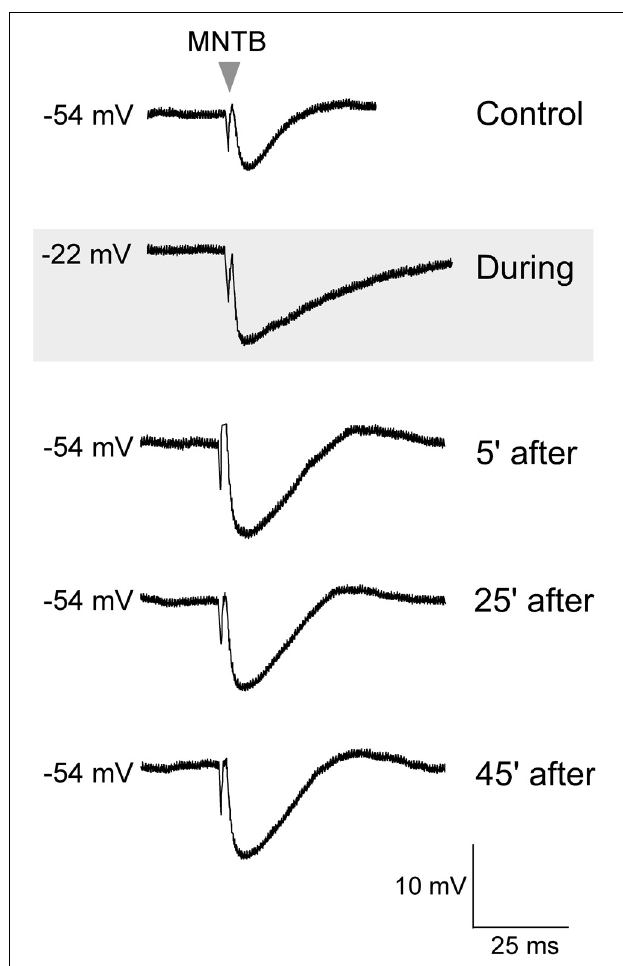
FIGURE 2 | Glutamate exposure potentiated MNTB-evoked IPSPs. Control MNTB-evoked IPSPs were recorded at 0.033Hz. An initial response is shown in the top trace. While continuing with this stimulation, glutamate (10mM) was bath perfused (45s), and the neuron became depolarized (gray panel), and discharged intensely (not shown). After the cell had completely repolarized to its original resting potential, the IPSP amplitudes were significantly larger. Baseline IPSPs (pre glutamate) and those acquired during glutamate exposure and then at 5, 25, and 45min after the cell had repolarized are